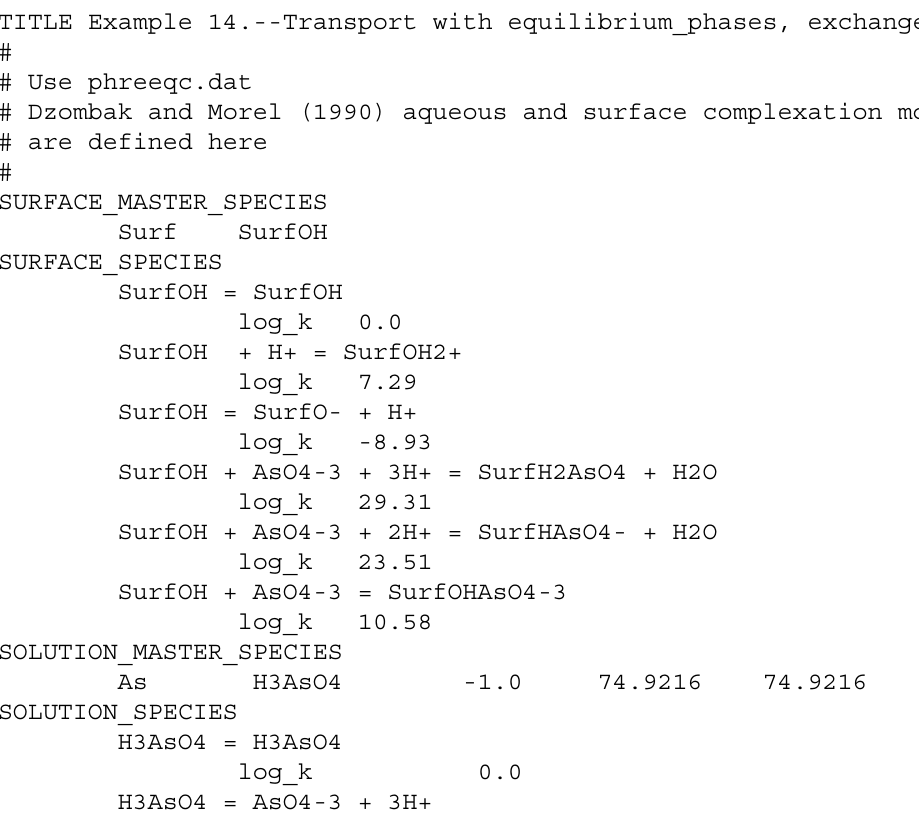
Table 37. Input file for example